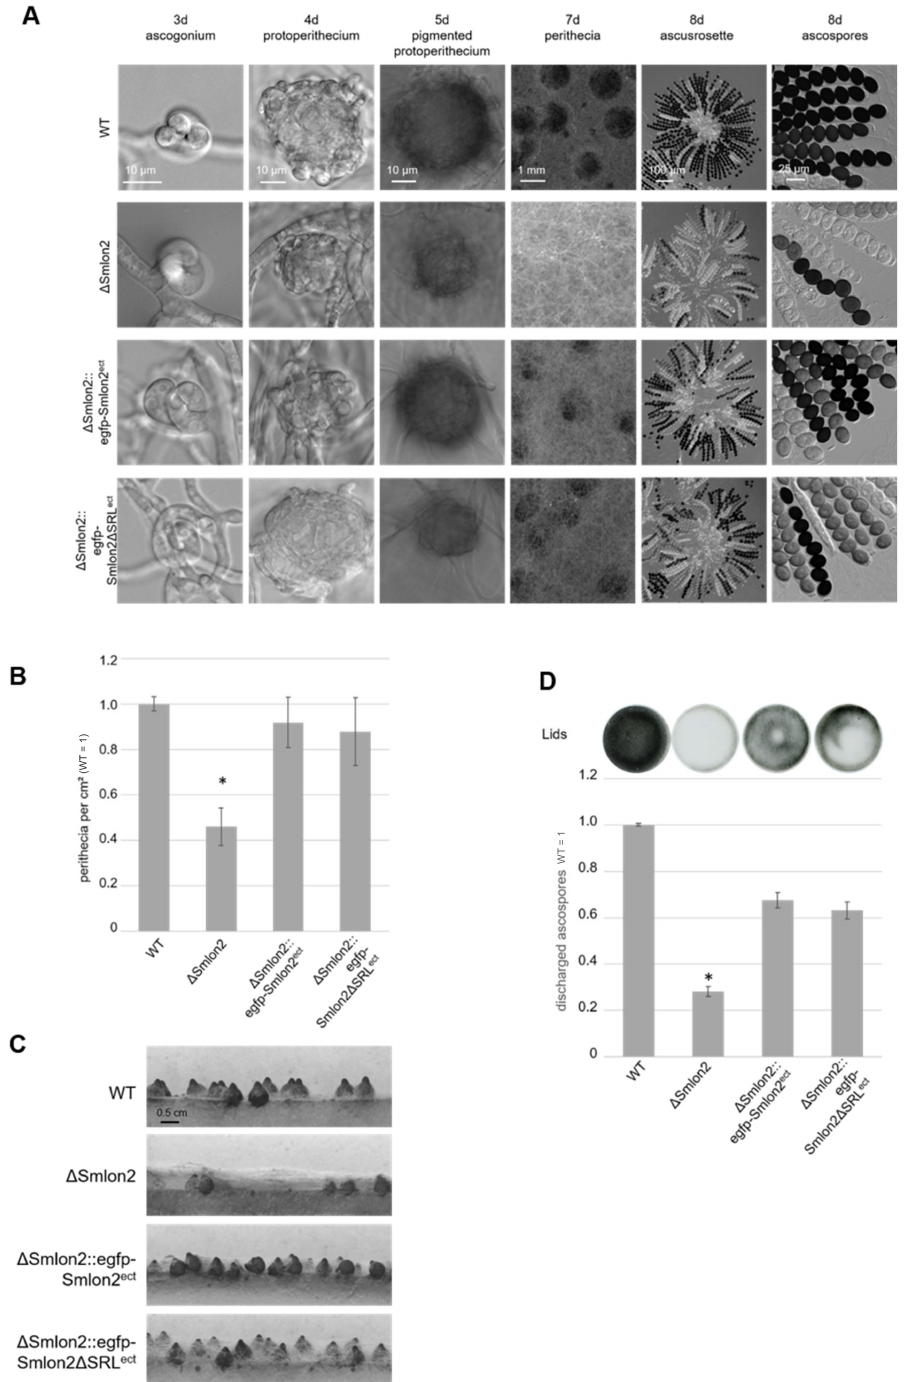
Figure 4. Phenotypic analysis of S. macrospora WT, ∆ Smlon2 mutant strain and complementation strains expressing variants of Smlon2 . Microscopic investigation of sexual development of WT compared to ∆ Smlon2 and the complementation strains ∆ Smlon2::egfp-Smlon2 ect and ∆ Smlon2::egfp-Smlon2 ∆ SRL ect . ( A ) Strains were grown on slides covered with fructification medium (SWG) at 27 ◦ C, and photographs were taken at indicated days. ( B ) Perithecia were counted per cm 2 after 8 d. Number of perithecia shown are averages relative to the WT from ten technical replicates of three independent experiments ( n = 30). ( C ) Side view of the strains after inoculation on solid SWG medium for 10 d at 27 ◦ C. The solid medium was sliced into thin strips that were microscopically investigated. ( D ) Ejected ascospores, after 10 d of growth, from the lid of a petri dish (56.7 cm 2 ) for the different strains. The results are averages relative to the WT from 5 technical replicates of three independent experiments ( n = 15). A representative picture of a lid is shown above the diagram. (*) Asterisks indicate significant differences to the WT of p < 0.0001 according to Student’s t-test. Scale bars are shown in the